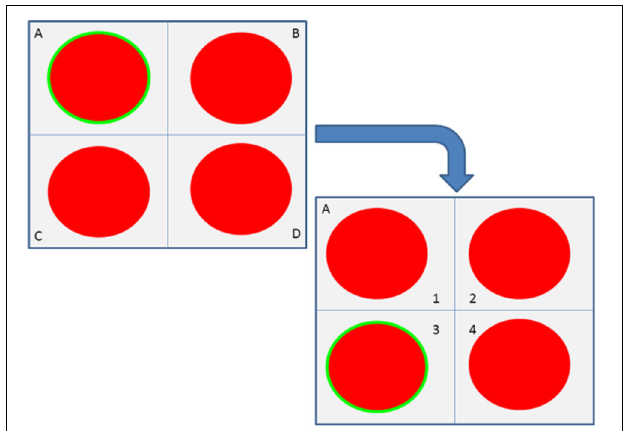
FIGURE 4 | Principle of the recursive and enforced selection during SG4. For example the user first selects the “A” quarter which is then zoomed in to allow the subject to select the “3” quarter. The resulting final selection is “A.3.”